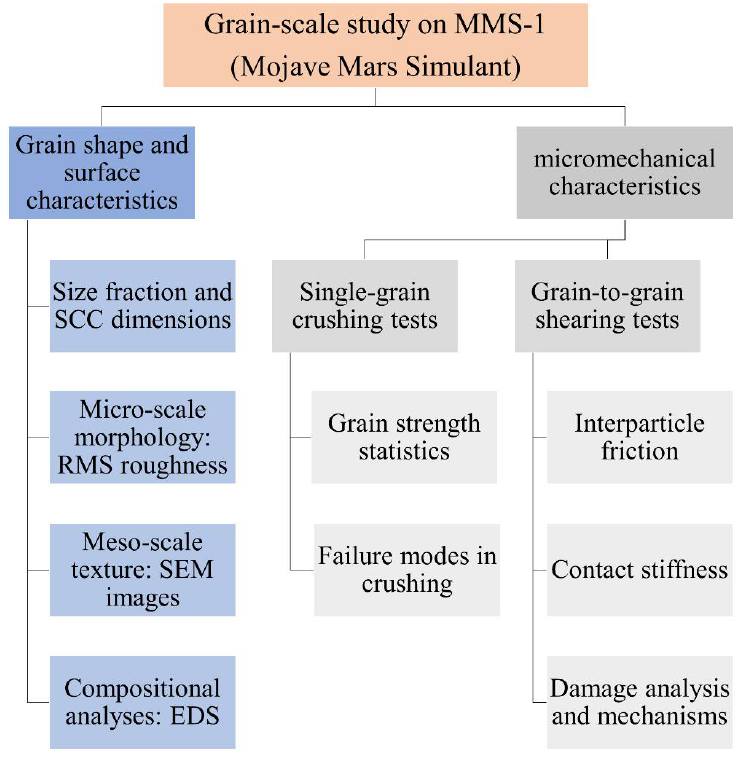
Figure 3. Illustration of the workflow in the present grain-scale study on MMS-1.